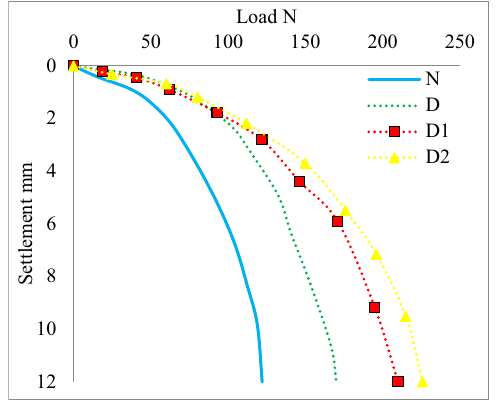
Figure 13: Load – settlement relations for footings resting on soil grouted outside the footing area to a depth of 6 cm.